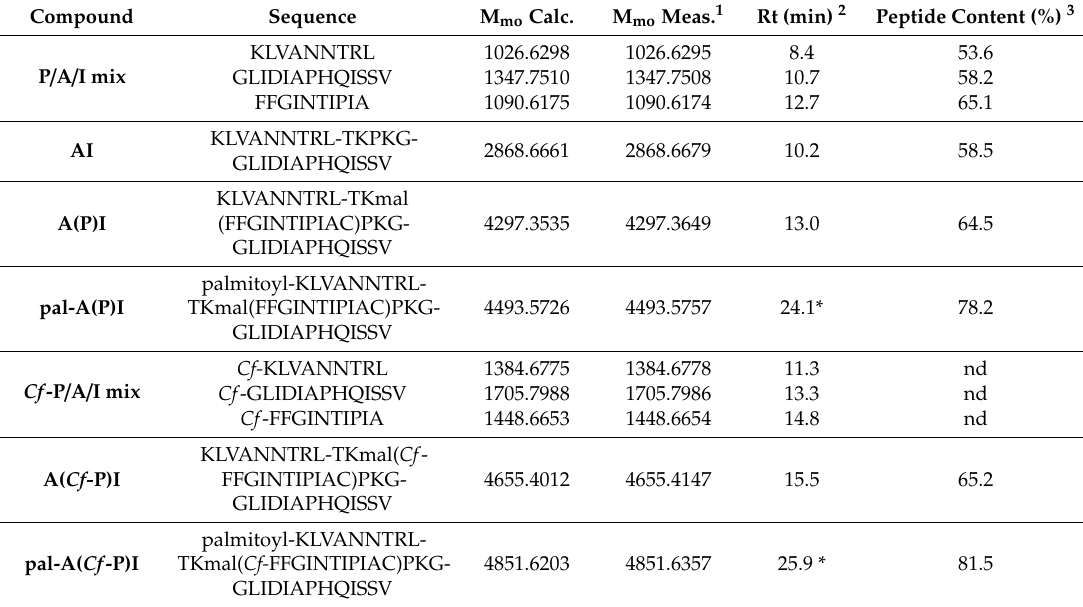
Table 1. Analytical characteristics of the peptides and peptide conjugates.